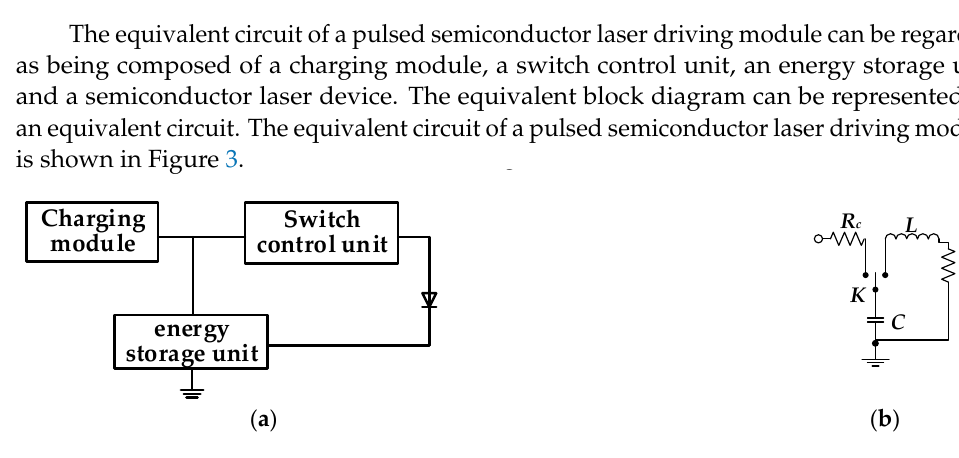
Figure 2. The circuit module composition of the laser ranging system.